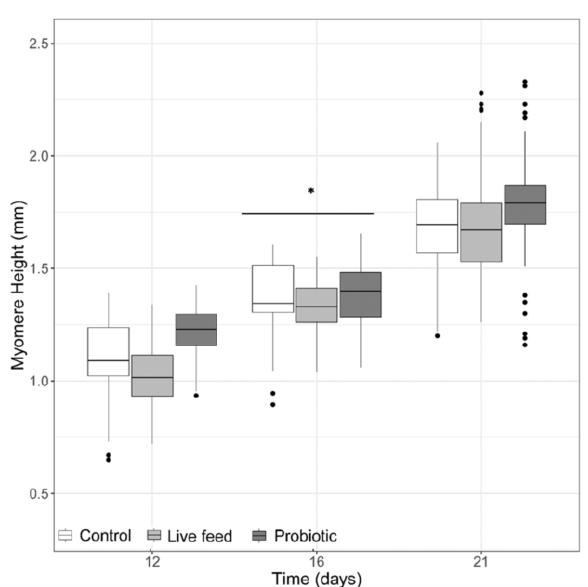
Figure 2. Larval myomere height from three treatments at days 12 ( n = 40), 16 ( n = 40), and 21 dph ( n = 100). Dots shown are the out layers, whiskers indicate the maximum and minimum values excluding out layers, the line in the middle of box is the median value and upper and lower quartiles are the ends of the box. Statistically significant differences between treatments are marked with an asterisk.